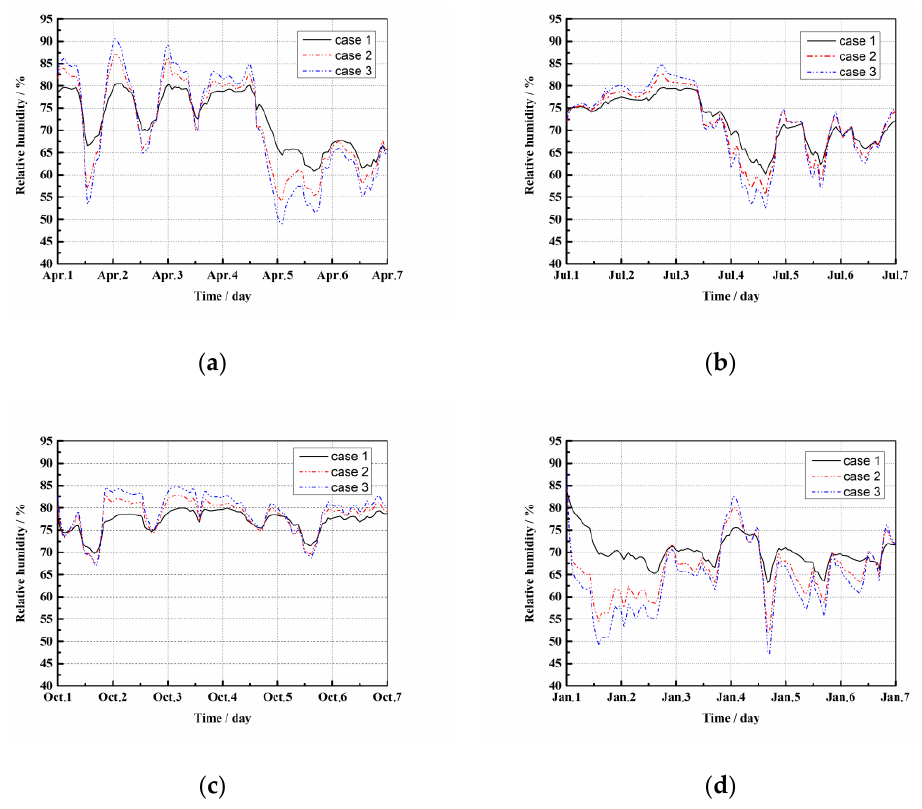
Figure 10. Indoor relative humidity in each season: ( a ) in spring; ( b ) in summer; ( c ) in autumn; ( d ) in winter.